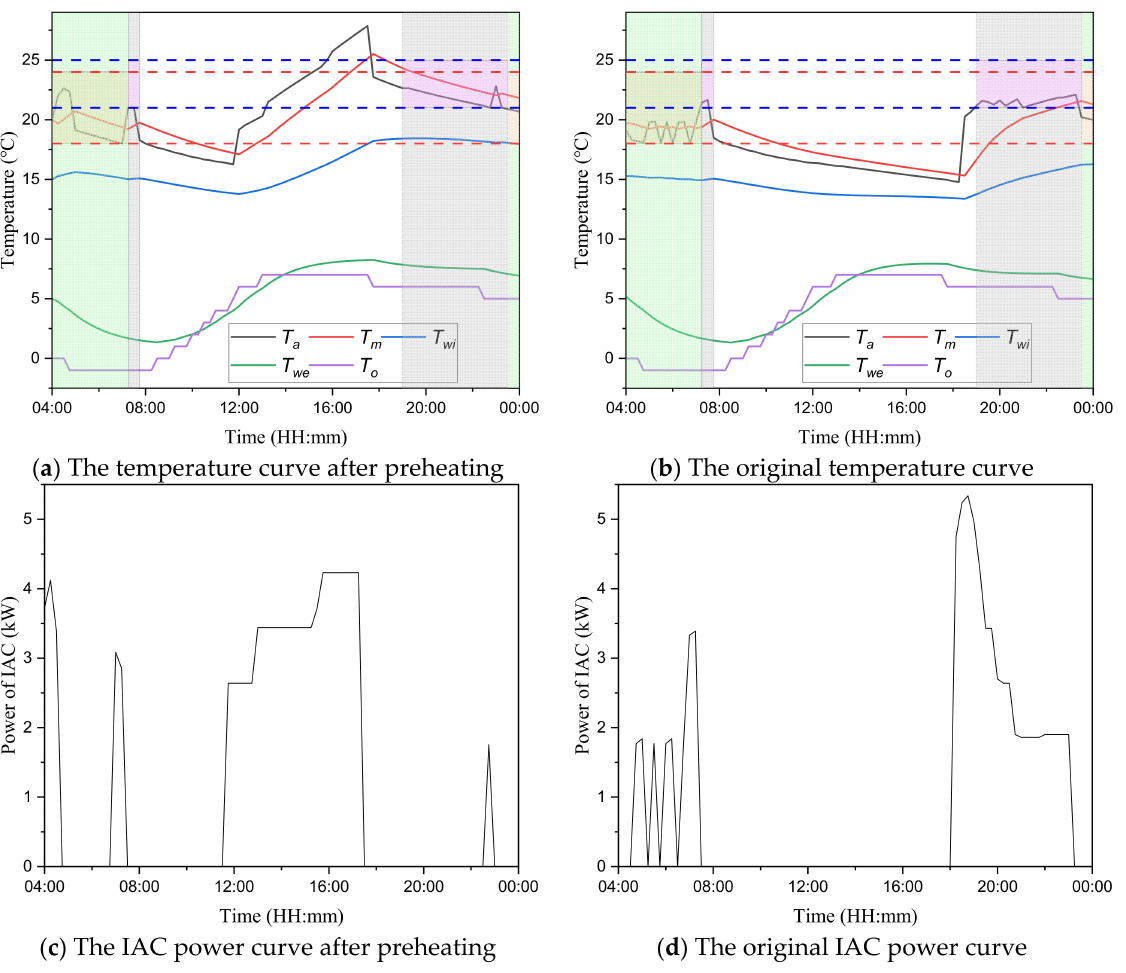
Figure 11. Comparison between optimization curves and original curves of a family participating in the Round